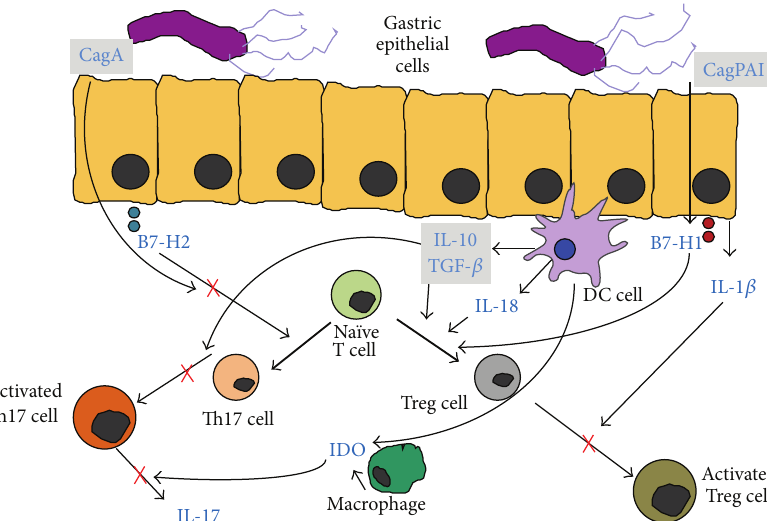
Figure 2: The impaired Th17/Treg balance. The induction of Treg cell differentiation is mediated by the overexpression of B7-H1 due to H. pylori cag PAI [41]. On the other hand, the CagA-induced lowered B7-H2 signaling inhibits Th17 cells development from na¨ıve T CD4+ cells [42]. The higher expression of IDO downregulates IL-17 production [36]. DCs promote Tregs differentiation through higher production of IL-18 [44] as well as by a transforming growth factor- (TGF-) 𝛽 /IL-10-dependent mechanism, which in turn blocks the Th17 cell proliferation [43]. The efficiency of Treg cells themselves is impaired by the production of IL-1 𝛽 enhanced by the bacterium